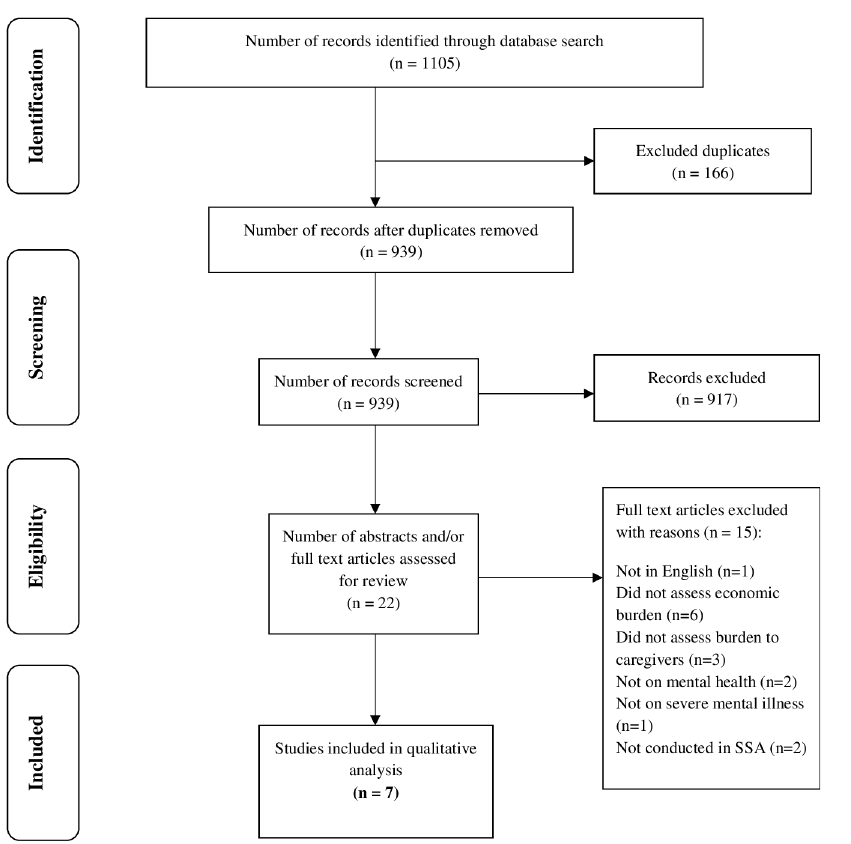
Fig 1. Flow diagram illustrating the steps involved in the review